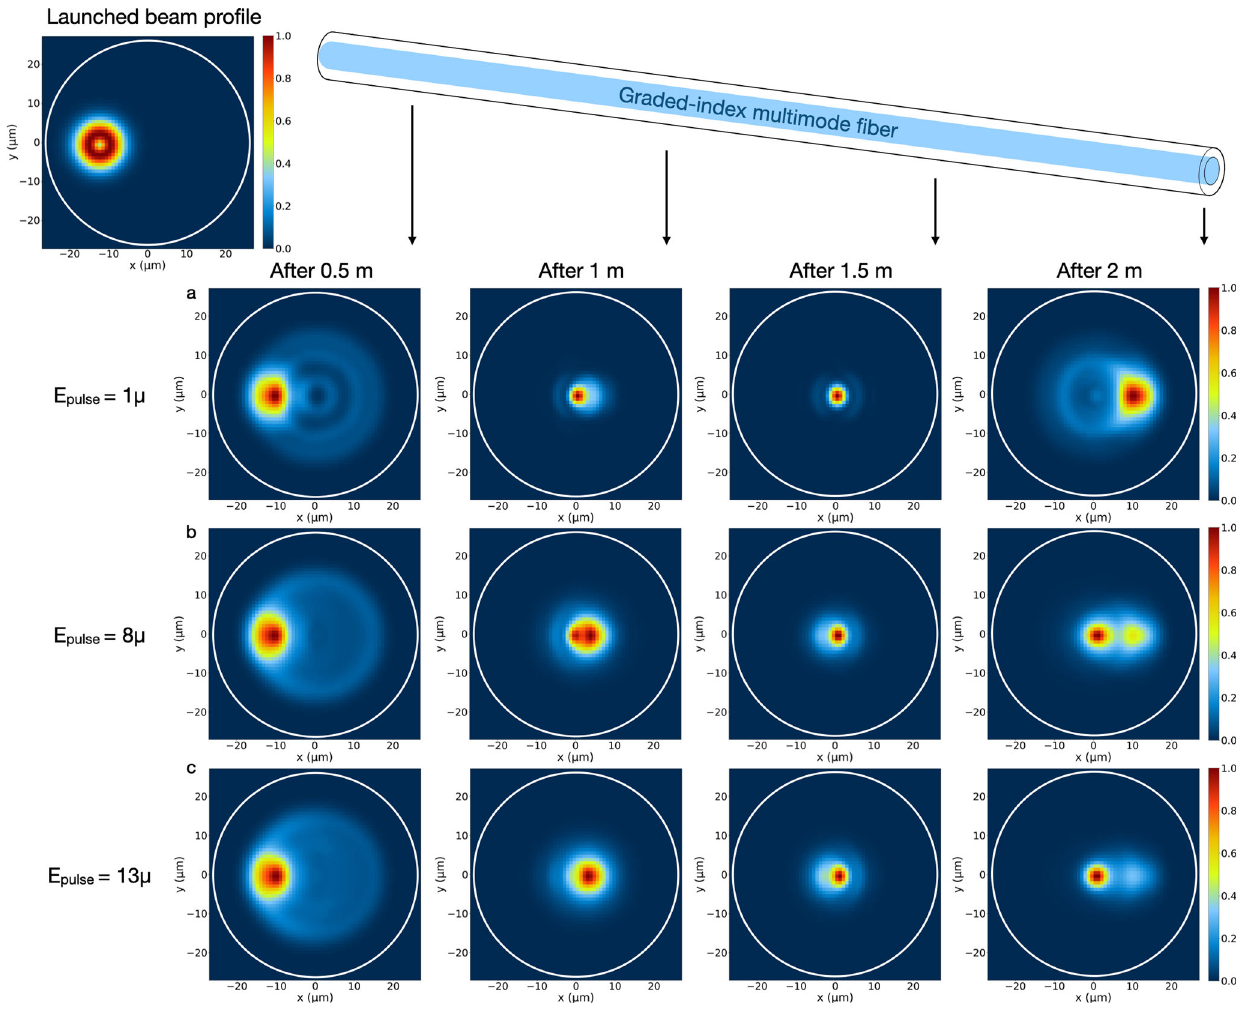
Fig. 5 Time-dependent beam propagation simulations inside the graded-index multimode fi ber. a Spatial evolution of the pulse with the average pulse energy. b Spatial evolution of the pulse with eight times the average pulse energy. c Spatial evolution of the pulse with thirteen times the average pulse energy. Launched beam pro fi le of the pulses is presented at top corner and solid circles indicate the core size of the GRIN